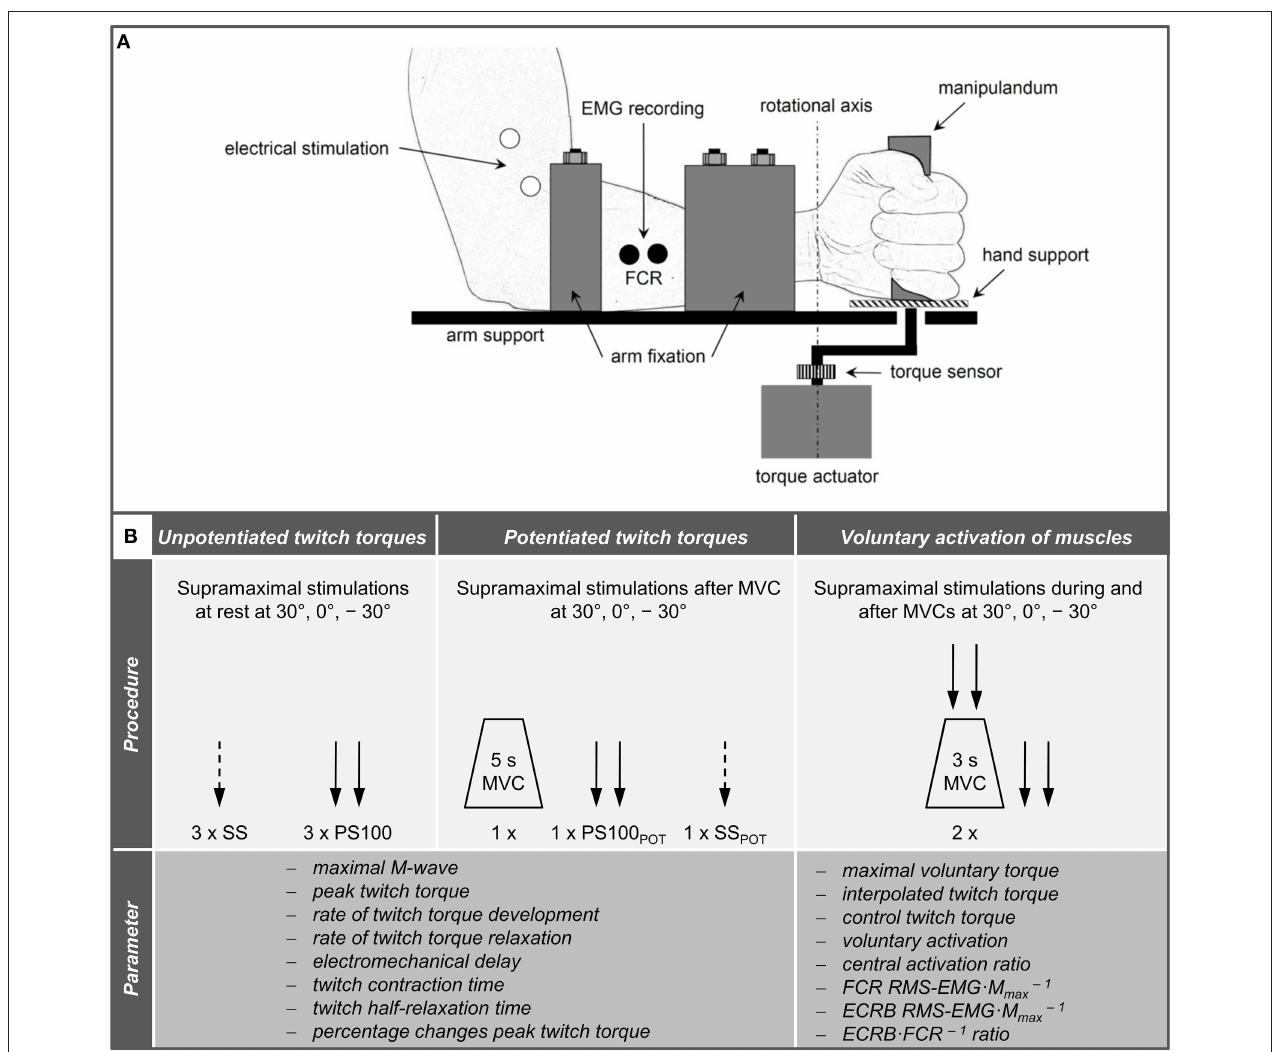
FIGURE 1 | Schematic representation of the experimental setup (A) and chronology of the procedures carried out during neuromuscular testing and the extracted parameters (B) . Please note that the hand fixation is not displayed and the order of the wrist joint angles was randomized. ECRB, extensor carpi radialis brevis; FCR, flexor carpi radialis; MVC, maximal voluntary contraction; PS100, unpotentiated twitch torques evoked by paired electrical stimuli at 100Hz [inter-stimulus interval (ISI) 10ms]; PS100 POT , potentiated twitch torques evoked by paired electrical stimuli at 100Hz [ISI 10ms] RMS · M − 1 , normalized root mean square of the EMG signal; SS, unpotentiated twitch torques evoked by single electrical stimuli; SS POT , potentiated twitch torques evoked by single electrical stimuli; − 30 ◦ , extension: long wrist flexor muscle length; 0 ◦ , neutral: intermediate wrist flexor muscle length; 30 ◦ , flexion: short wrist flexor muscle